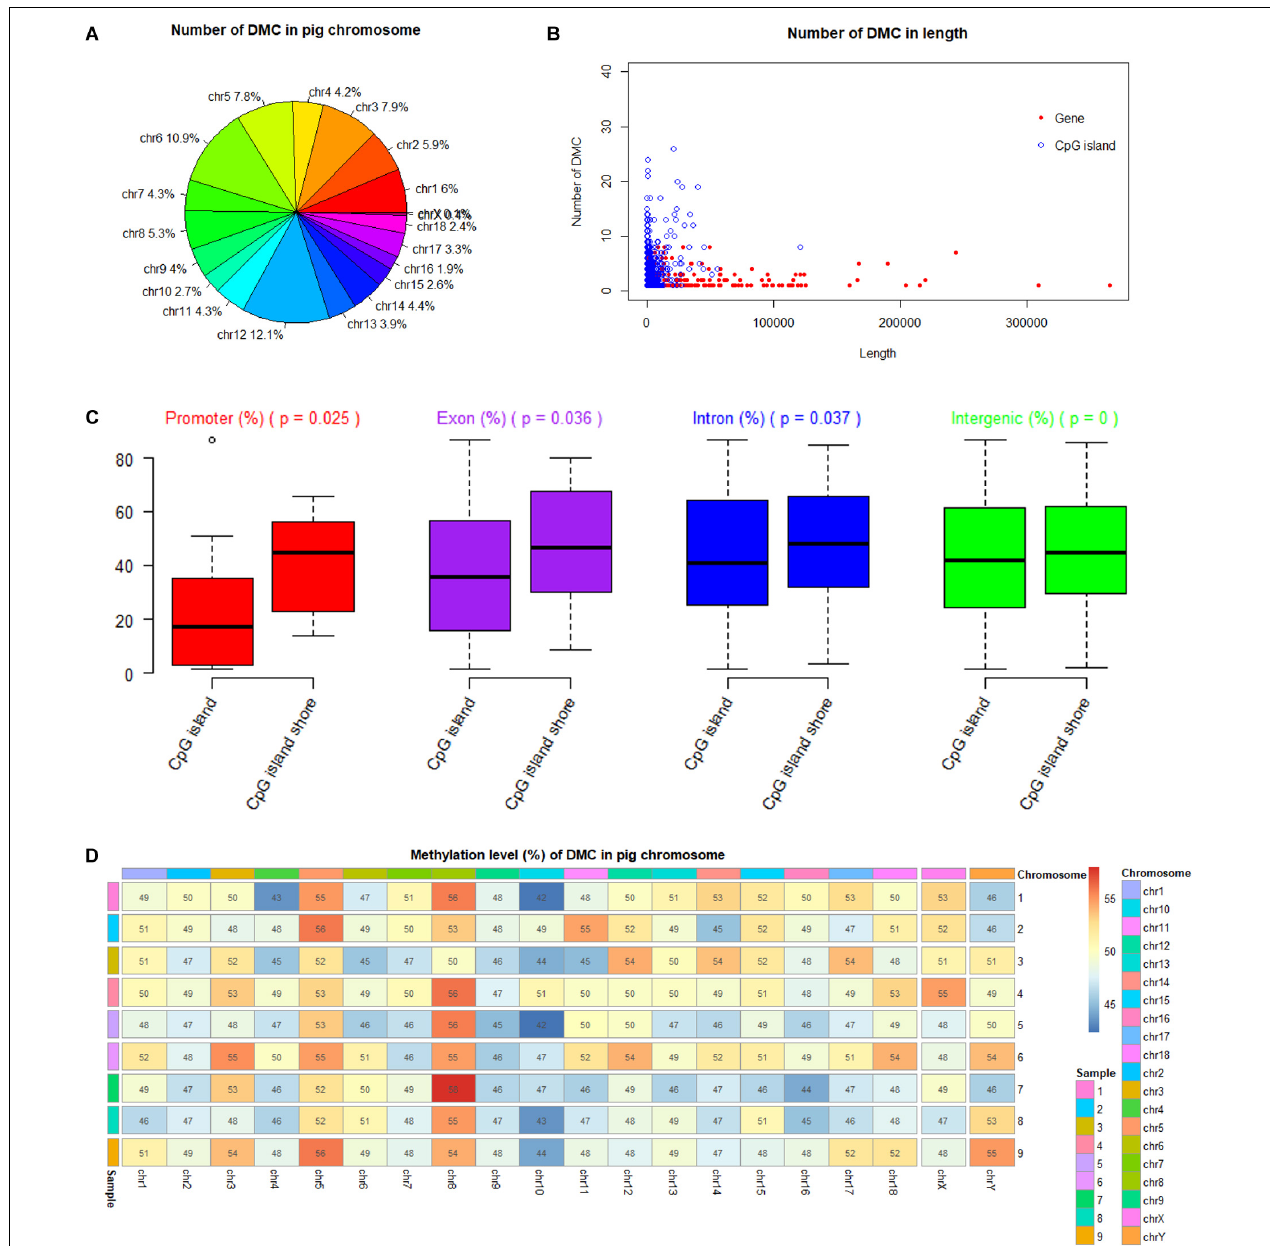
FIGURE 5 | Methylation status of DMC in porcine chromosomes, genic features and CpG islands. (A) Number of DMC in different pig chromosome. (B) Number of DMC in the different lengths of genes and CpG islands. (C) Comparison of methylation levels between CpG islands and CpG island shores at different genic feature with Student’s t -tests. (D) Methylation levels of DMC in different pig